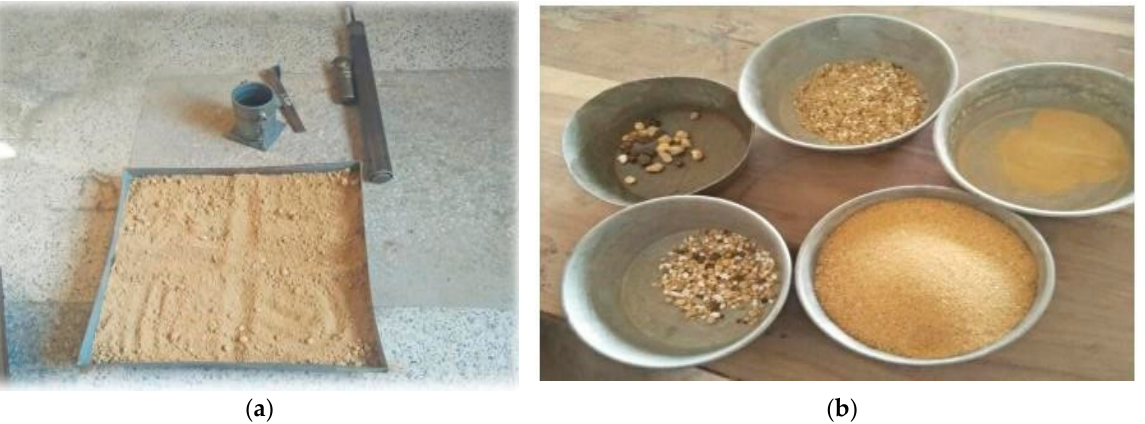
Figure 2. Pit Test. Figure 2. Pit Test.